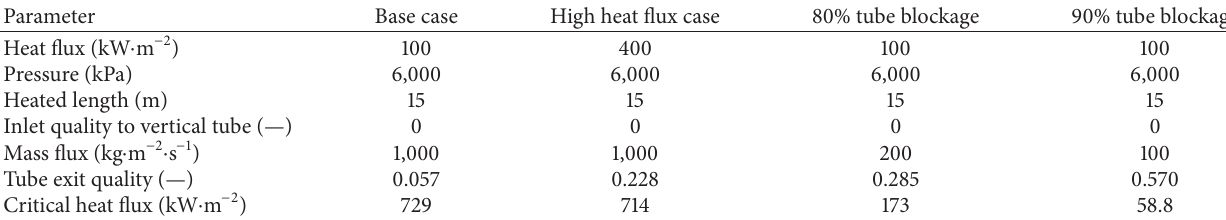
Table 4: Effect of high heat flux and tube blockage on CHF